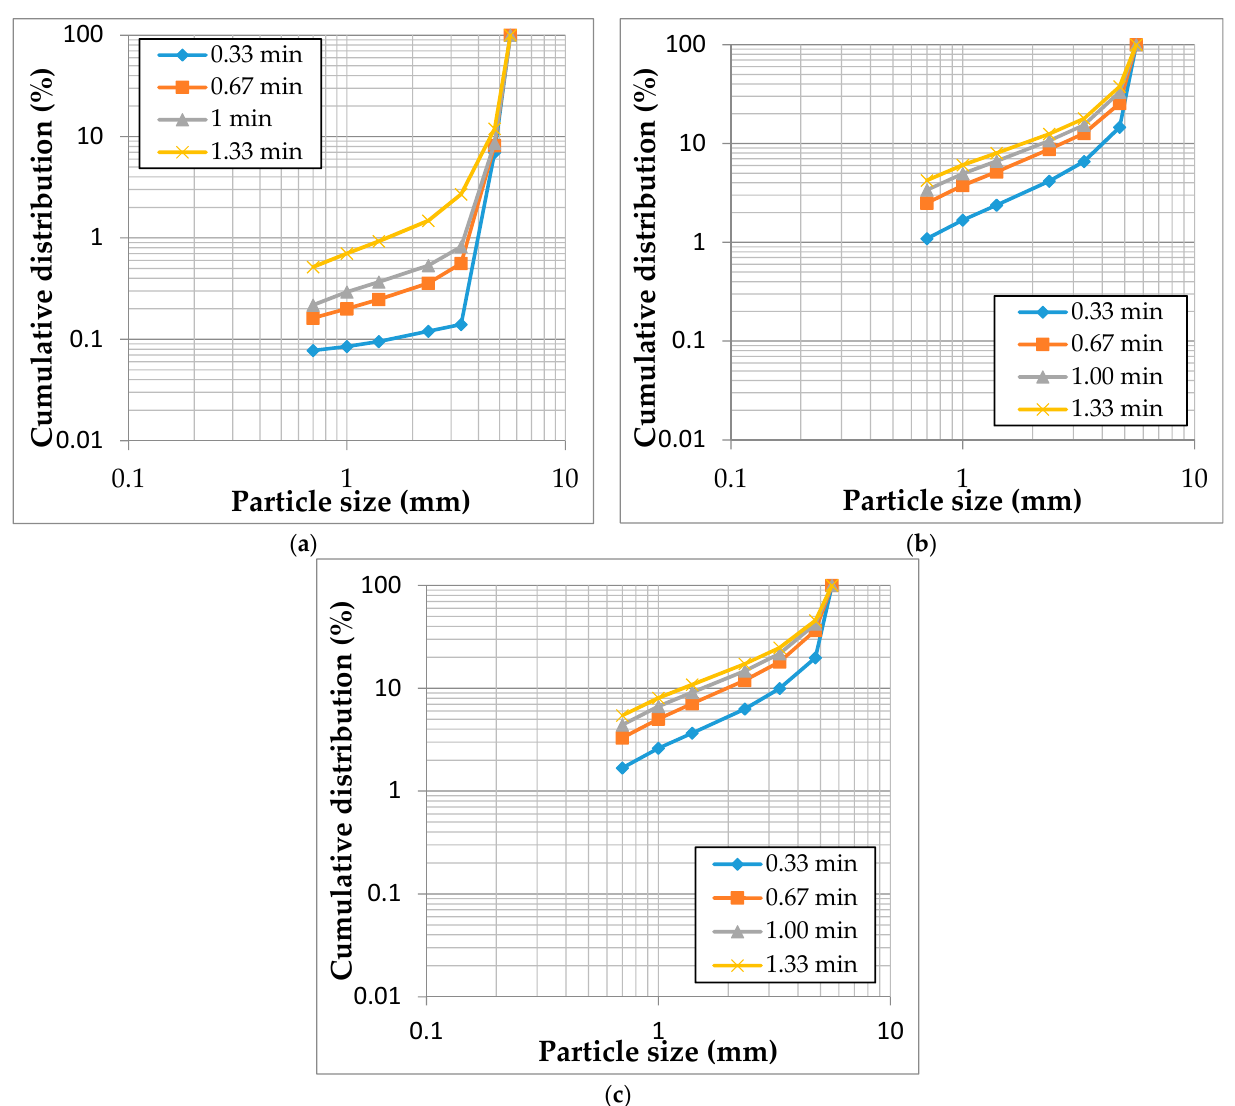
Figure 7. Cumulative passing rotor speeds ( a ) 510 rpm, ( b ) 885rpm, and ( c ) 1040 rpm for a 5.6 to 4.75 mm feed.